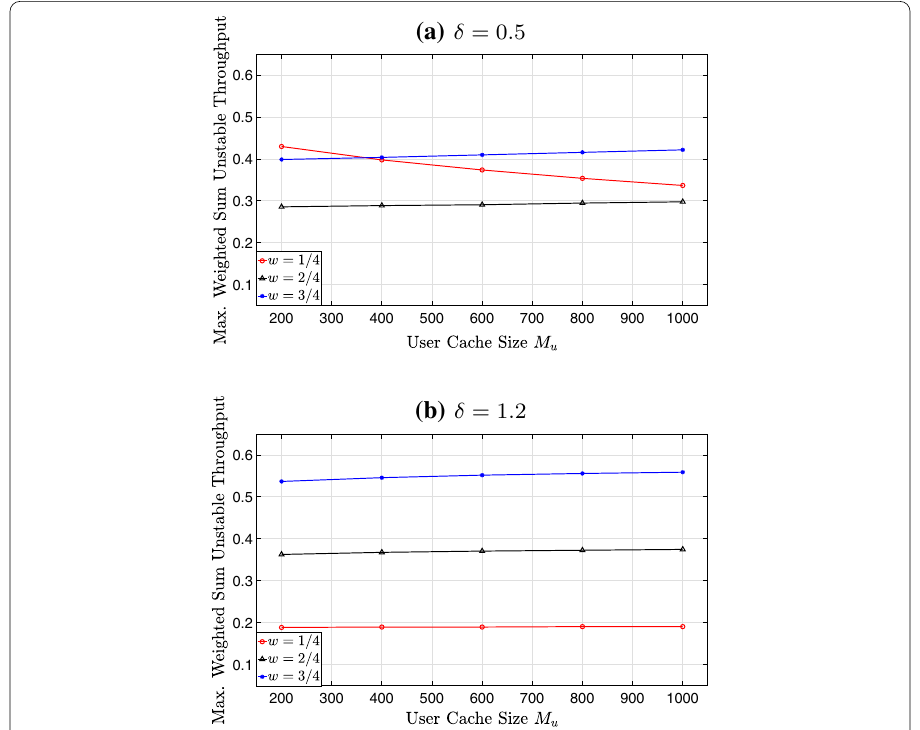
Fig. 7 The maximum weighted sum throughput vs. M U when the queue at S is unstable and α = 0.7 using different values of w for: ( a ) δ = 0.5 and ( b ) δ =